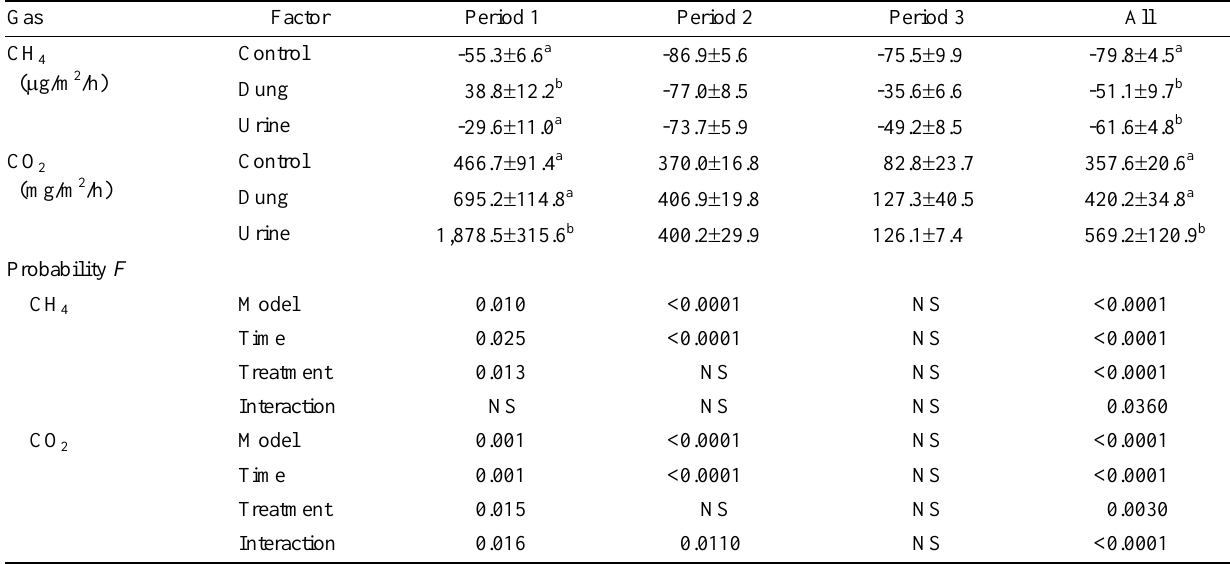
Table 1. Mean CH 4 and CO 2 flux (mean ± SE) for control, dung and urine treatments for three periods and the whole study period